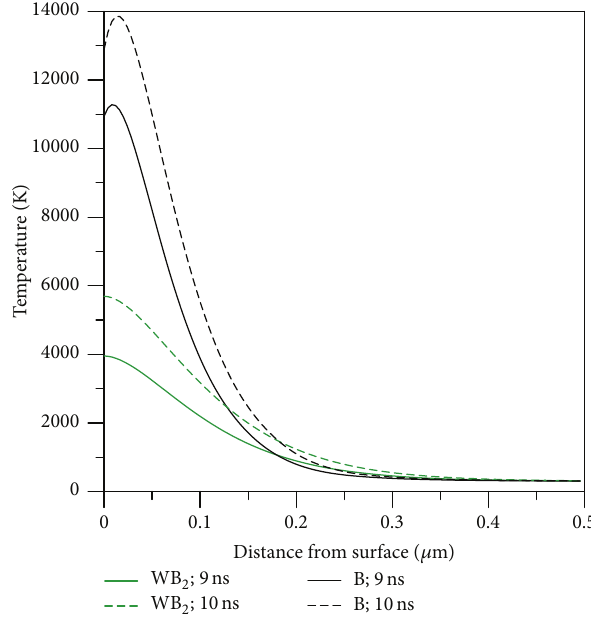
Figure 8: Distribution of target temperature along the axis at 9th ns and 10th ns from the beginning of laser pulse. Targets material: WB 2 and B; laser radiation 355 nm.